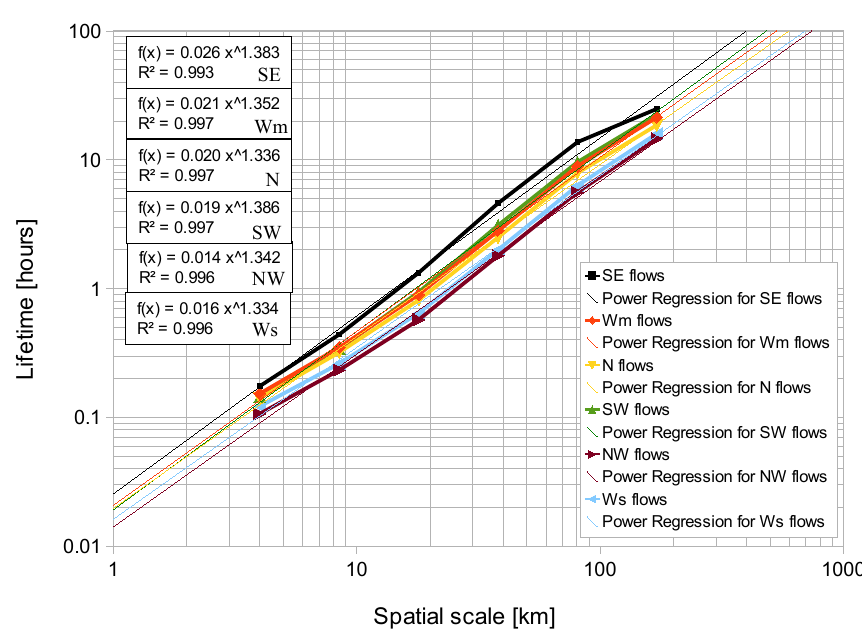
Figure 5. Dynamic scaling relationship between the spatial scale and precipitation lifetime stratified by flow regime. The equations of the power law fits are shown in the upper left